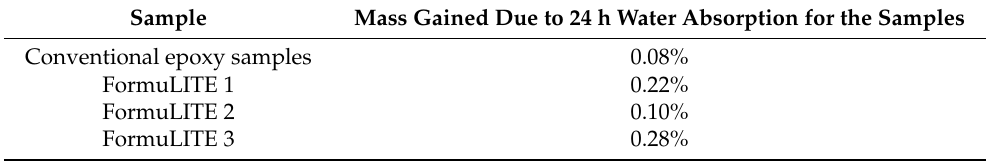
Figure 11. ( a ) Differences of means for hardness as per the ANOVA with Games–Howell comparison. ( b ) Interval plots of means of hardness versus test specimens. Table 5. Weight gained in 24 h water absorption test by the